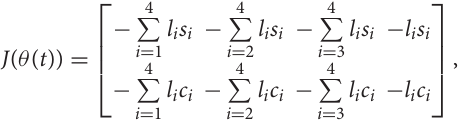
4) Multiple-harmonic noise with an aperiodic